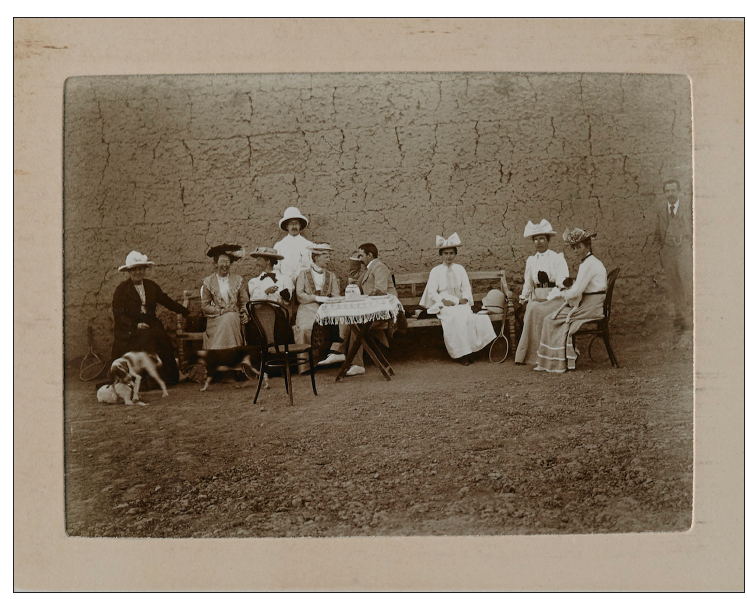
Fig. 2 : Tea at Nasrullah Khan’s house, 1903 (Ellen Tanner is fifth from the left). Photograph by Herbert Sykes, Sykes Family Collection.